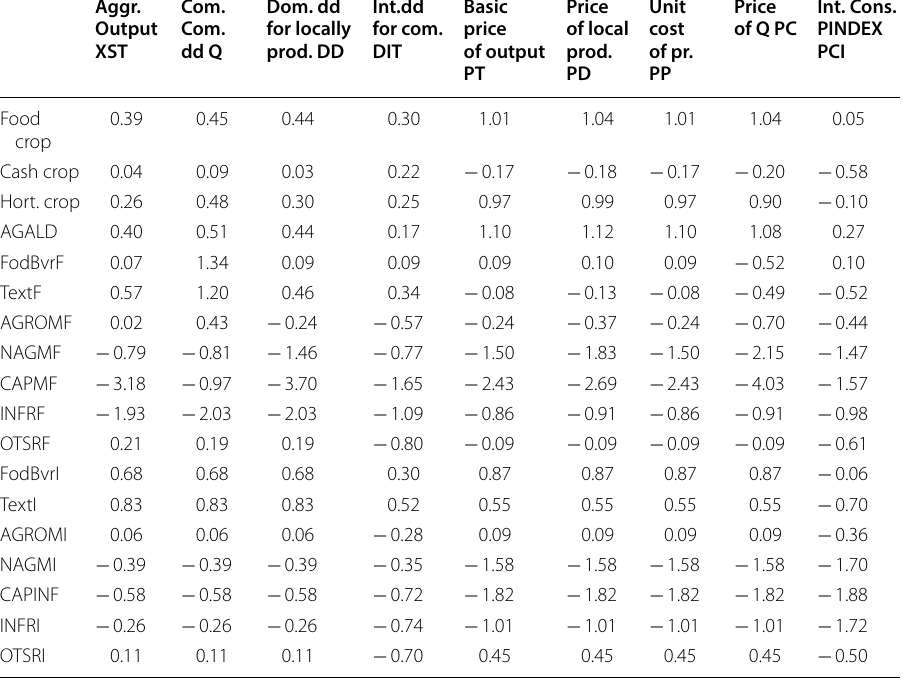
Table 1 (Scenario A1–S1) Change (%) in quantity and price due to 50% tariff reduction = 0.2 ). Source: based on simulation analysis (segmented labour market-1, σ LD j Aggr.